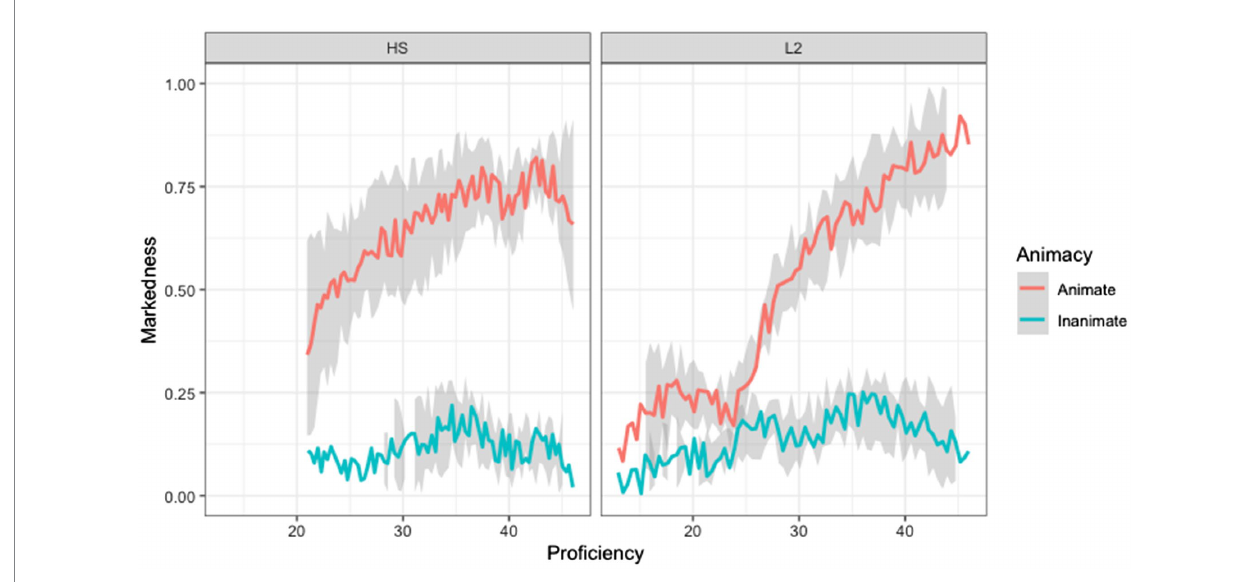
FIGURE 4 The effect of proficiency on the production of DOM (elicitation task).